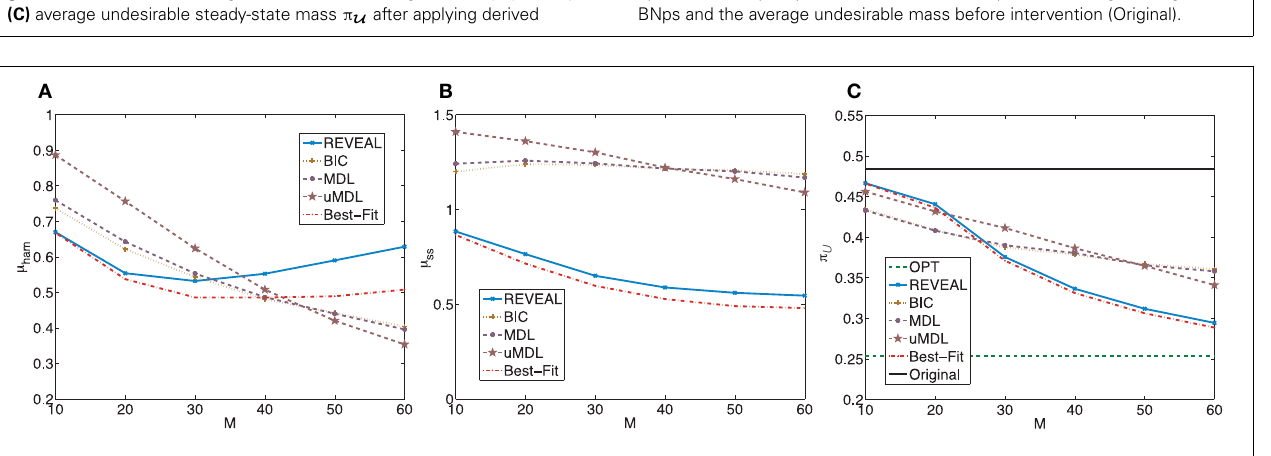
FIGURE 3 | Performance comparison of five network inference algorithms by different average validity indices based on BNps with 7 genes and K = 5. (A) Average normalized Hamming distance μ ham ; (B) μ ss ; (C) average undesirable steady-state mass π U after applying derived